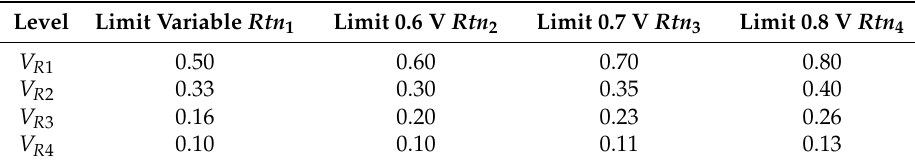
Table 2. Proposed routines and voltage values in each SC of the bank.